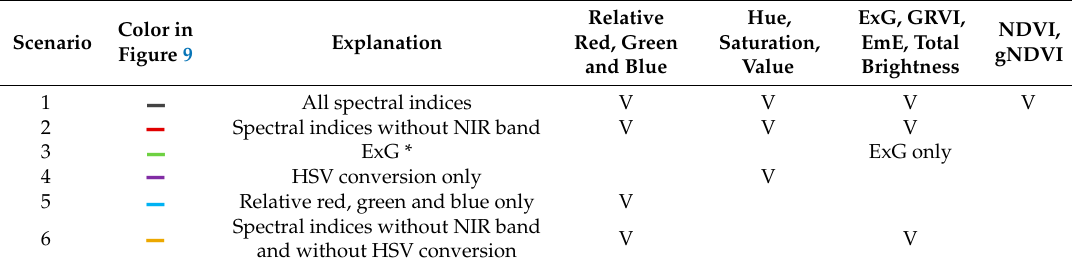
Figure 8. Total classification accuracy of the near-surface time series for different combinations of spectral indices, see legend in Table 4. The classification was carried out by RF classifier, using all spectral indices from the Sataf southern-facing site (S ′ S) observations ( 708 individuals, 11 species). Table 4. Different combinations of the spectral indices, as tested and presented in Figure 8.